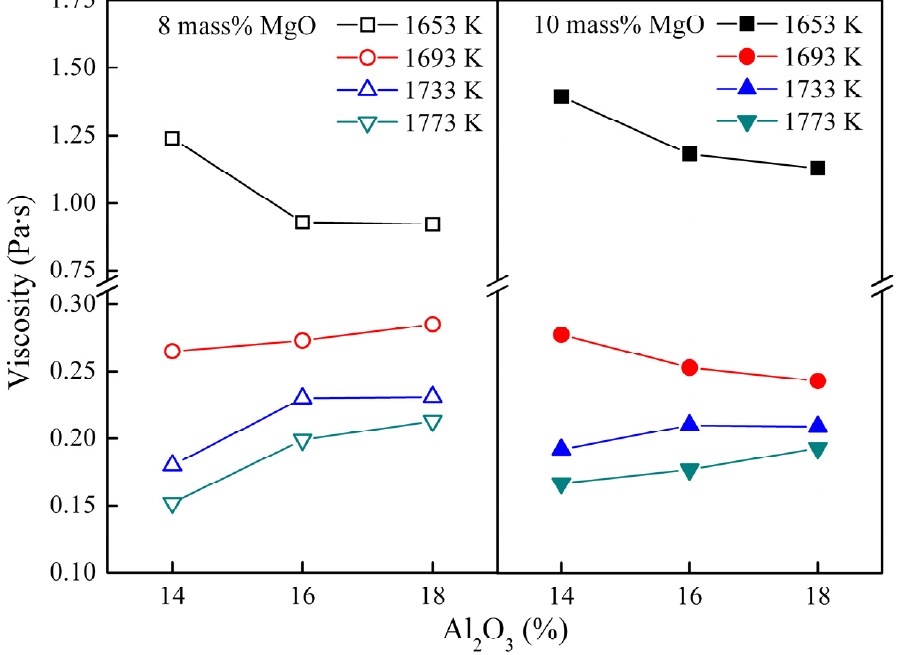
Figure 7. Viscosity of the CaO-SiO 2 -MgO-Al 2 O 3 -25 mass% TiO 2 (R = 1.10) slag as a function of mass% Al 2 O 3 .